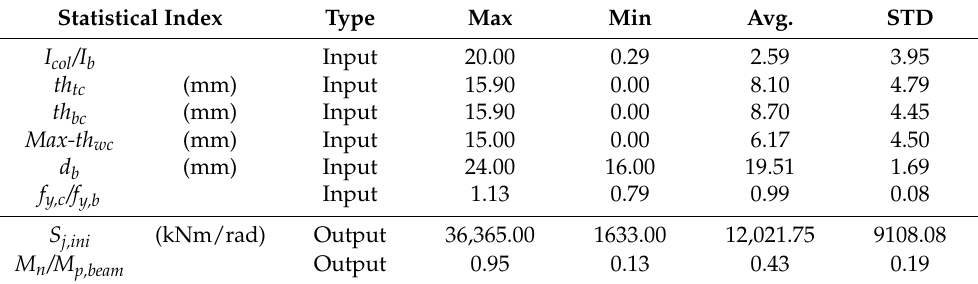
Table 2. Characteristics of input and output parameters for artificial neural network (ANN)